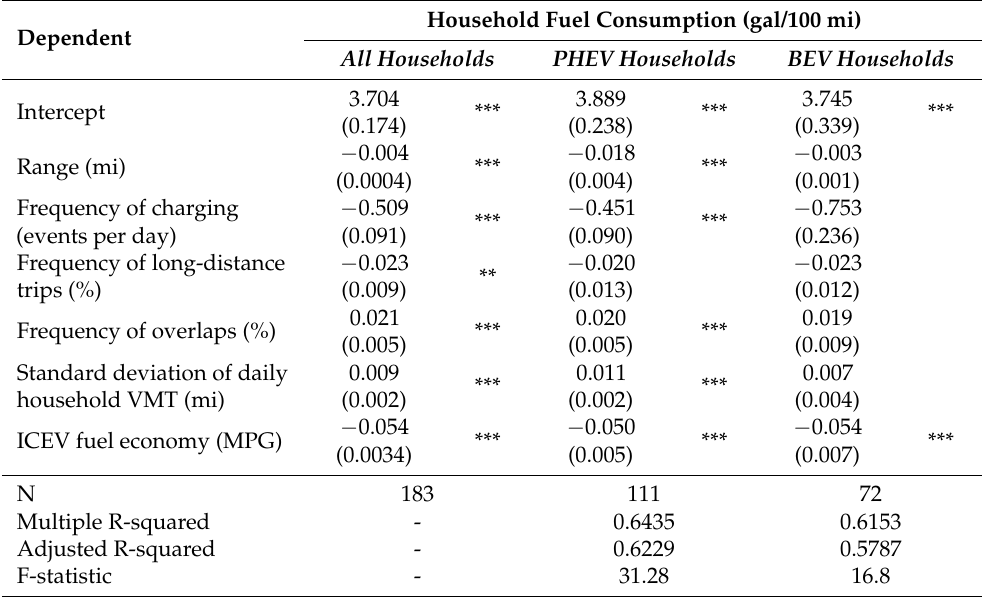
Table 4. Regression results for how household factors impact fuel consumption in two-car households.